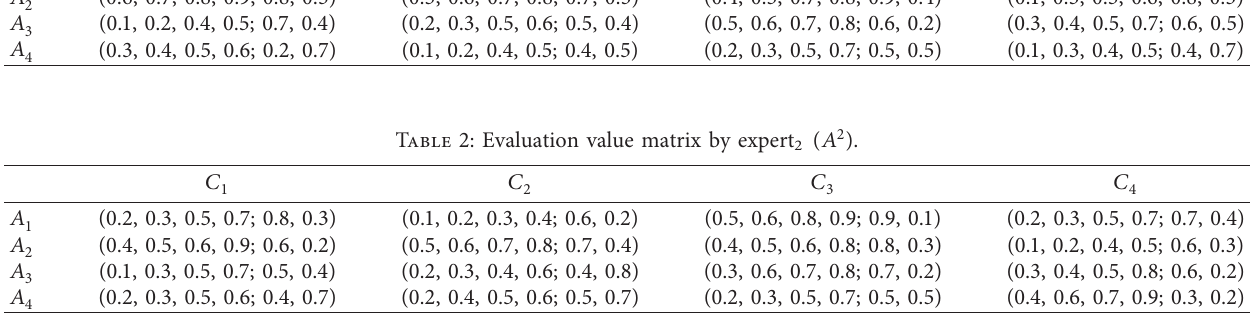
Table 3: Evaluation value matrix by expert